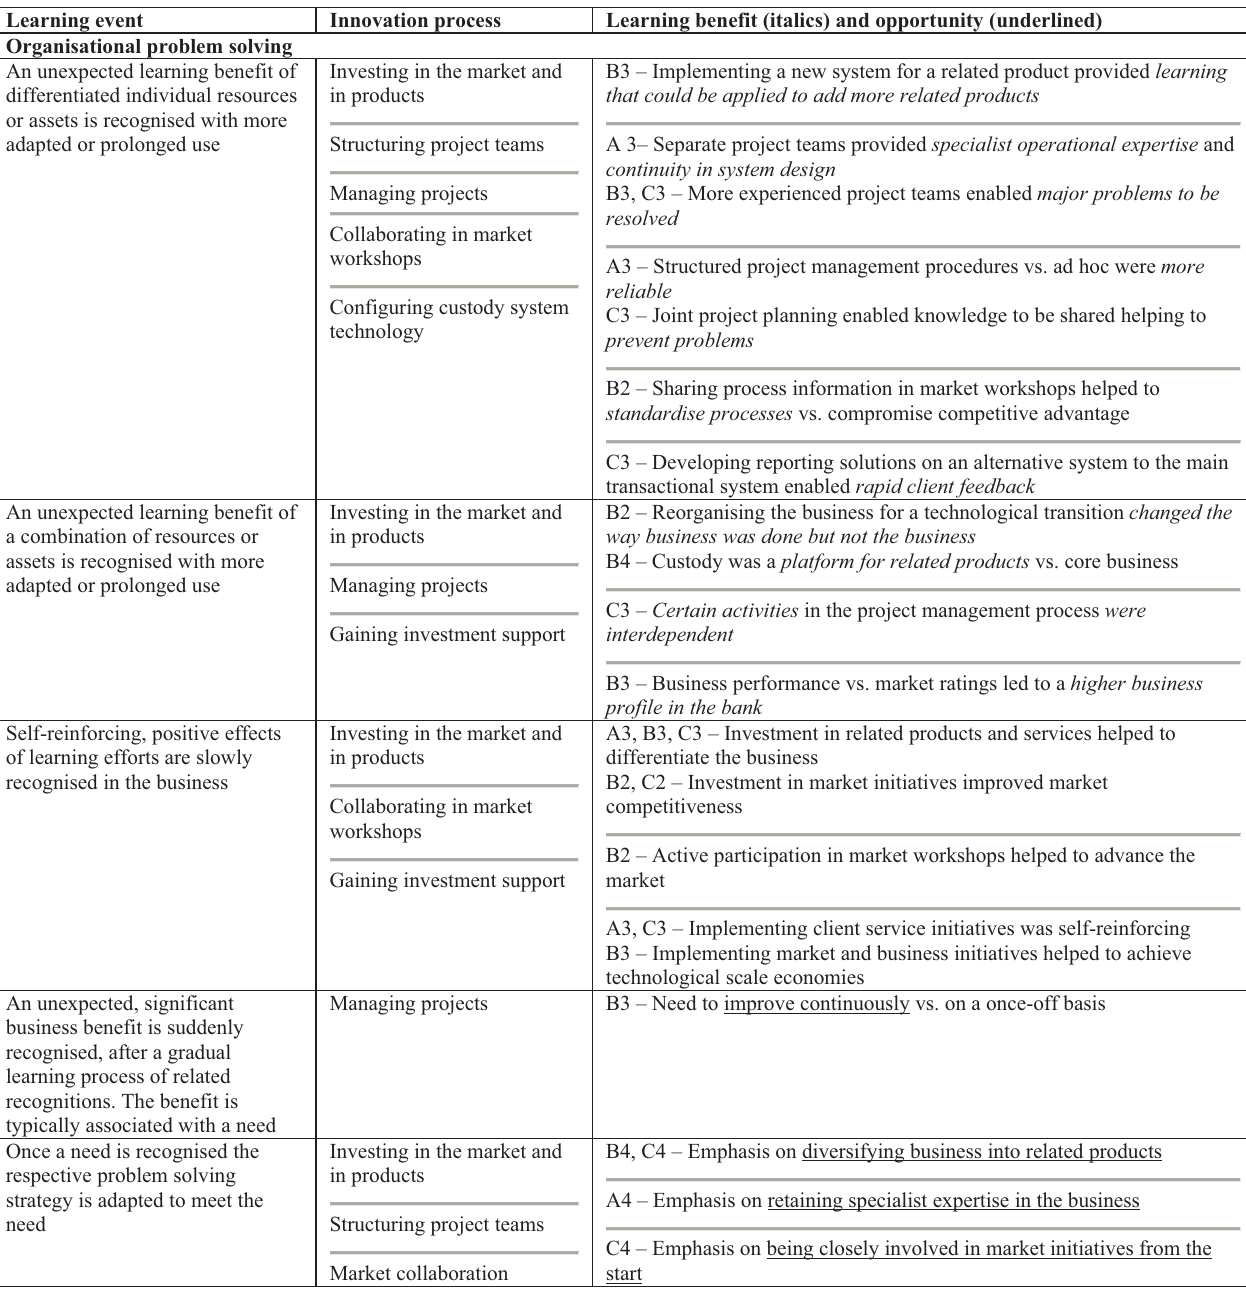
Table 2: ( Continued ) Learning event Innovation process Learning benefit (italics) and opportunity (underlined) Organisational problem